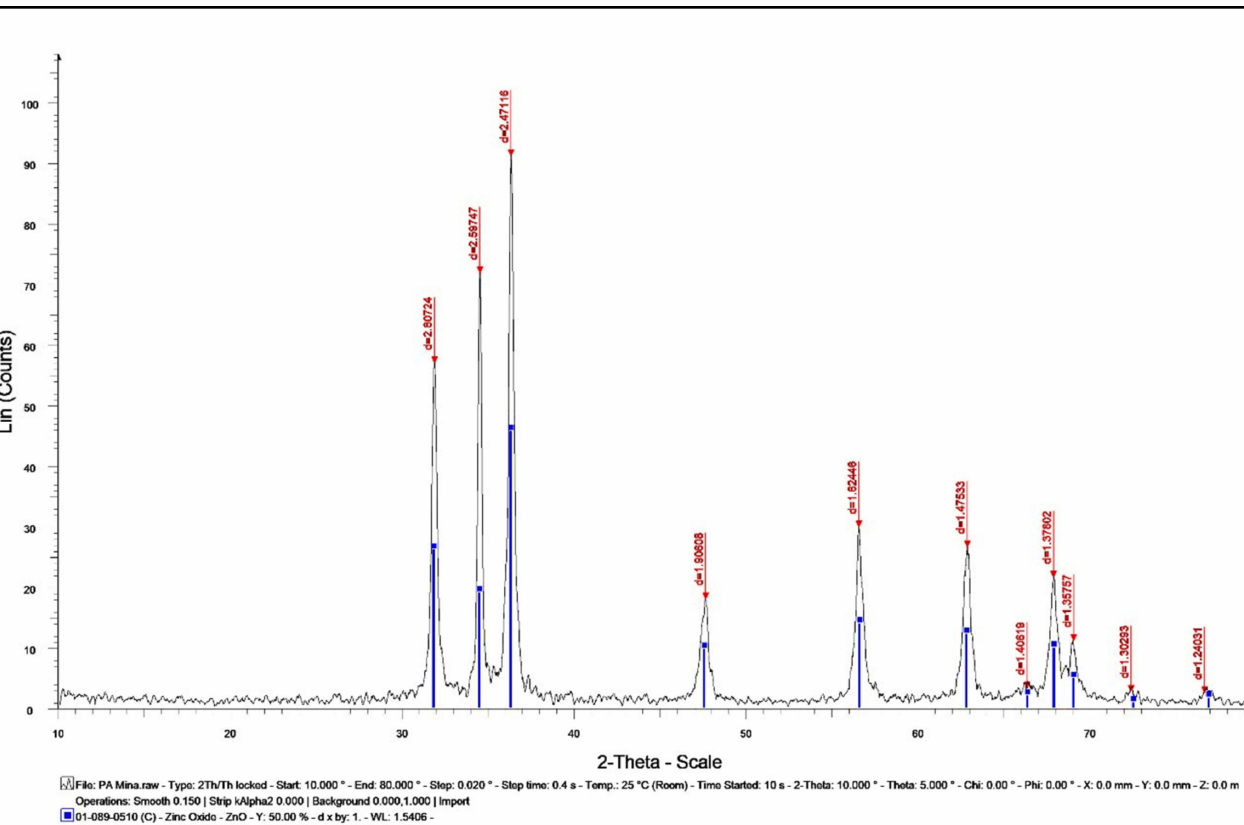
Figure 10. XRD analysis of ZnO